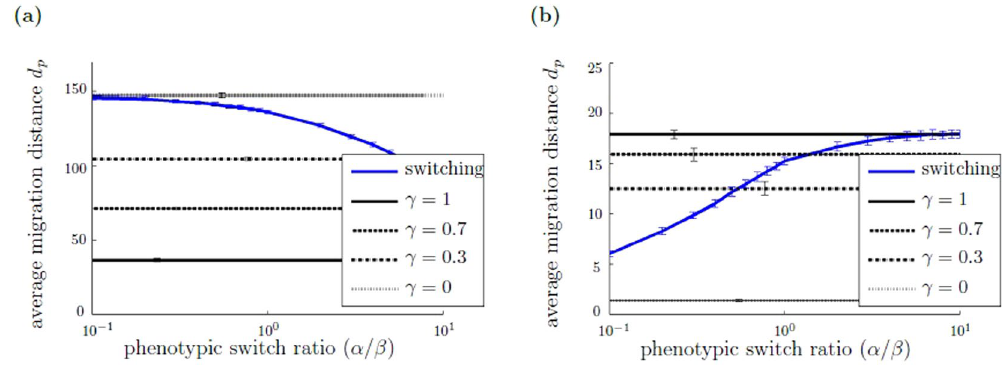
Table 2. As a final step, we study if cooperative effects in a switching population contribute to an efficient migration of the entire cell population. To this end, we compare the migration behavior of a single cell moving alone with that of an individual cell moving in a cell population of size n = 500. In particular, we first simulate n repetitions of the single cell scenario, each time measuring the migration distance d of the single cell, and at the end determine the maximum migration distance d . Secondly, we simulate a cell population of size n , using the same model param- eters as in the single-cell scenario. We measure the migration distance d of each individual cell of the population and determine the maximum migration distance d Both simulations are repeated 100 times to account for sto- chastic fluctuations.